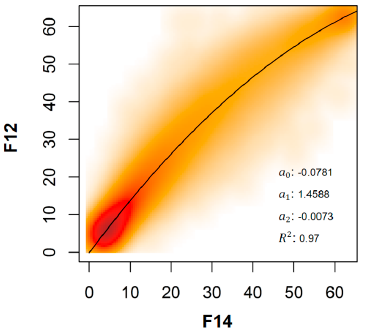
Figure 2. Relationship (and coefficients) of NTL DNs between F12 and F14 at overlaid years (1997, 1998, and